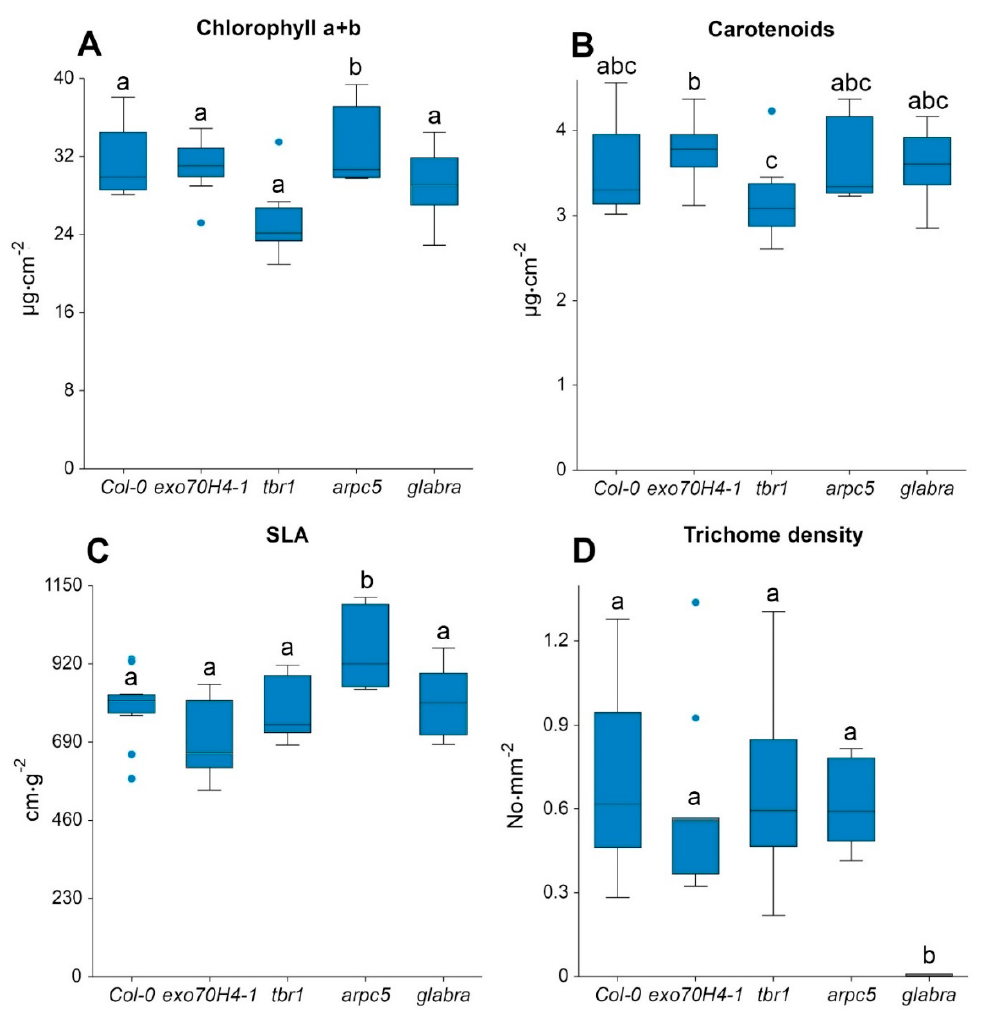
Figure 4. Leaf biochemical and structural parameters for A. thaliana lineages ( Col-0 , exo70H4-1 , tbr1 , arpc5 , and glabra ): ( A ) chlorophyll a + b content, ( B ) carotenoids content, ( C ) specific leaf area (SLA), and ( D ) trichome density. Differences among lineages were tested by one-way ANOVA. In the case of normal distribution, the Tukey–Kramer multiple comparison test was used; otherwise, the Kruskal–Wallis test was applied. Significance was set at a p -value < 0.05. Lines in boxes show median, bars show the inter-quartile range, and dots correspond to outliers.